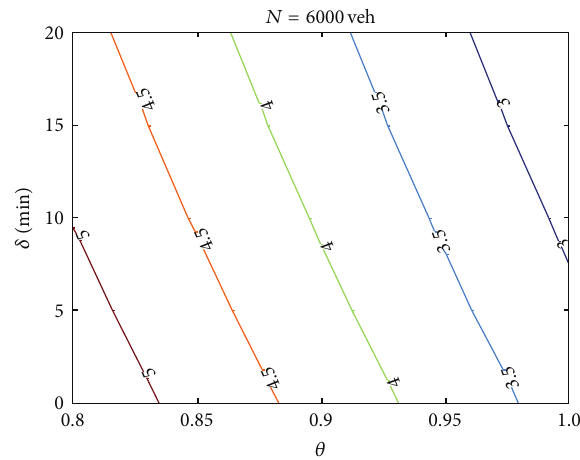
Figure 7: The equilibrium trip cost 𝐸[𝐶] with different 𝜃 and 𝛿 . the commuters’ departure time choice to follow the UE principle in terms of the mean trip cost. The analytical solution of the stochastic bottleneck model was derived. Both analytical and numerical results show that increasing the capacity variation results in longer peak period and higher commuters’ mean trip cost. In addition, it is shown that with longer flexi-time interval, the departure time